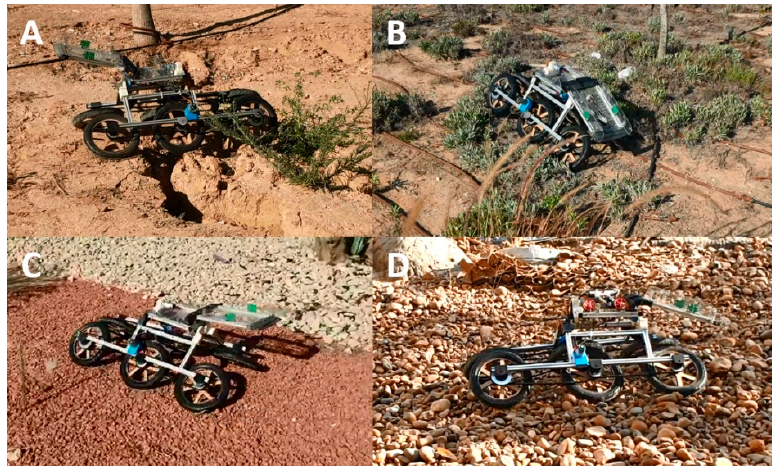
Figure 15. The BSTAR travelling over challenging terrains including cracks ( A ), dirt and vegetation ( B ), gravel ( C ), and stones ( D ) (see video in Supplementary Materials).